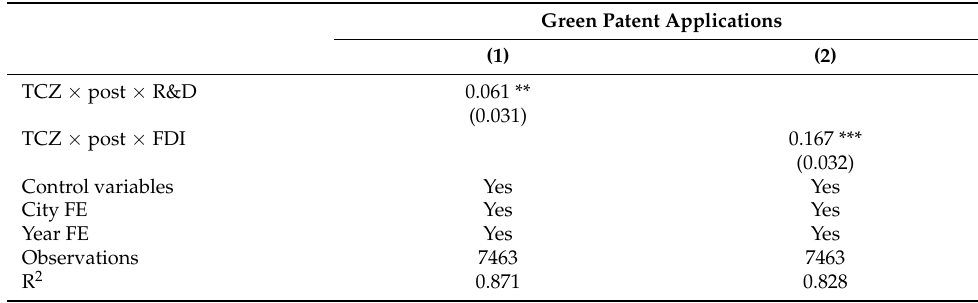
Table 5. Heterogenous effect of TCZ